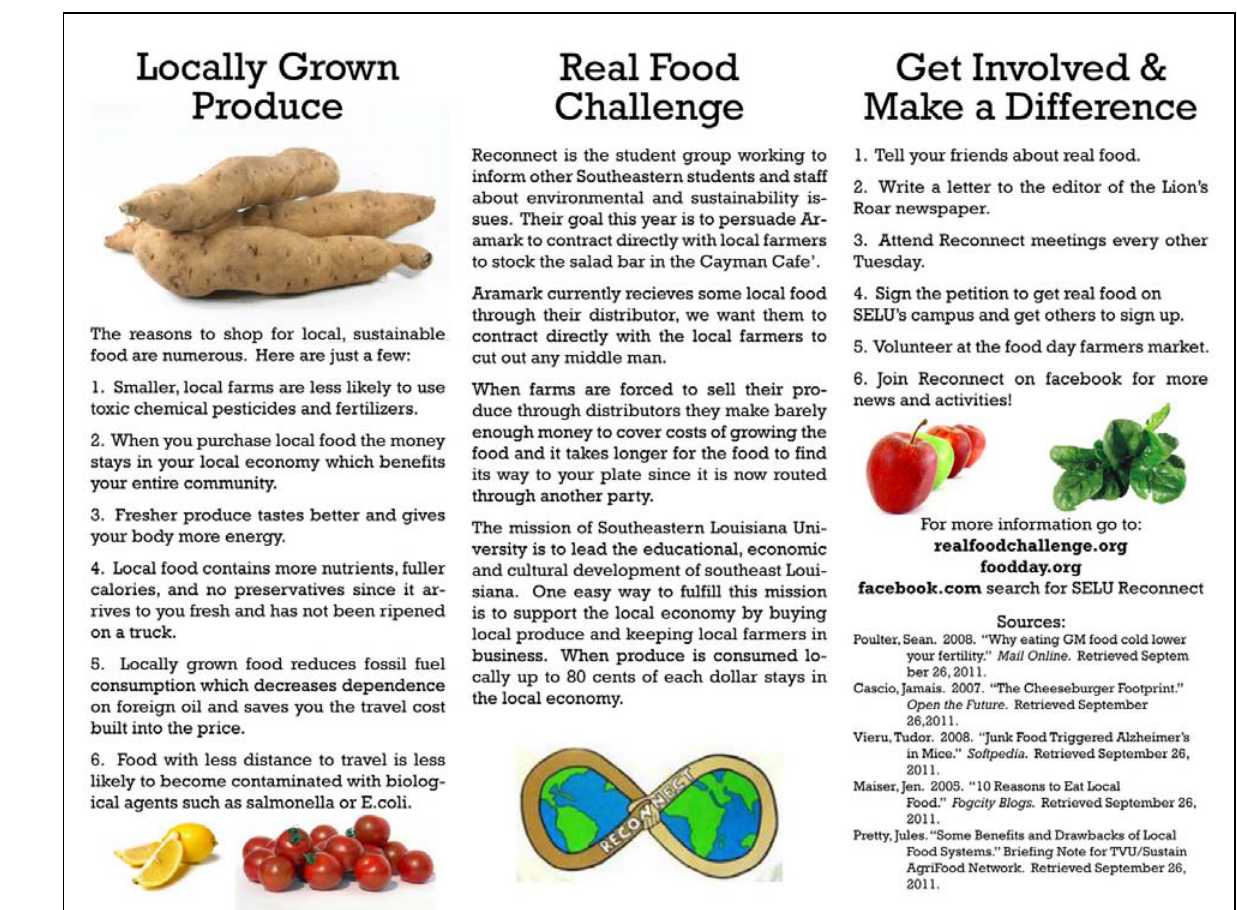
Figure 3. Side 2 of the Fold-up